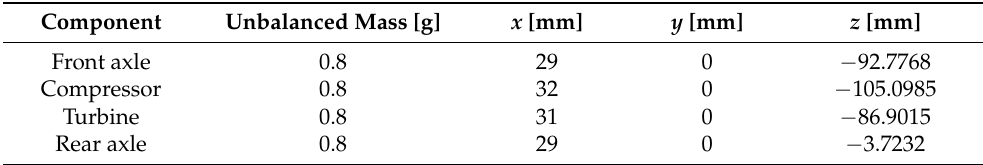
Table 2. The setup of the unbalanced masses and the corresponding coordinates in the high-pressure rotor system.